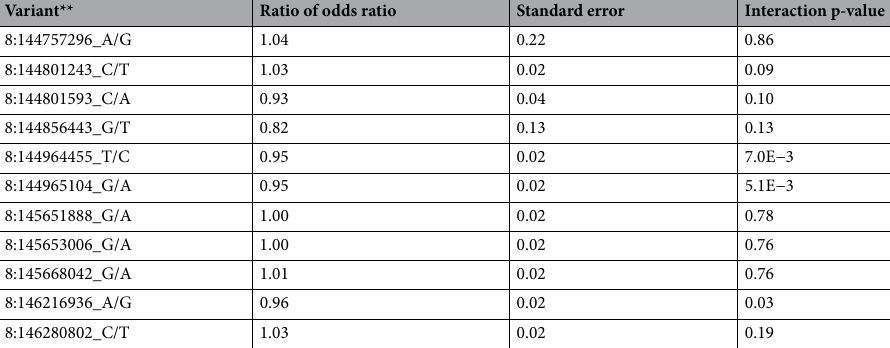
Table 4. Variant specific ratio of odds ratios associated with per quantile increase in sex-study specific quantiles of total folate consumption on colorectal cancer risk for variants included in TONSL*. Models were adjusted for age, sex, study, sex-study specific quartiles of total energy consumption in kcal, and principal components to account for population stratification. *Filtering to uncorrelated variants in TONSL (r 2 < 0.9). **Chromosomal position and reference/alternative